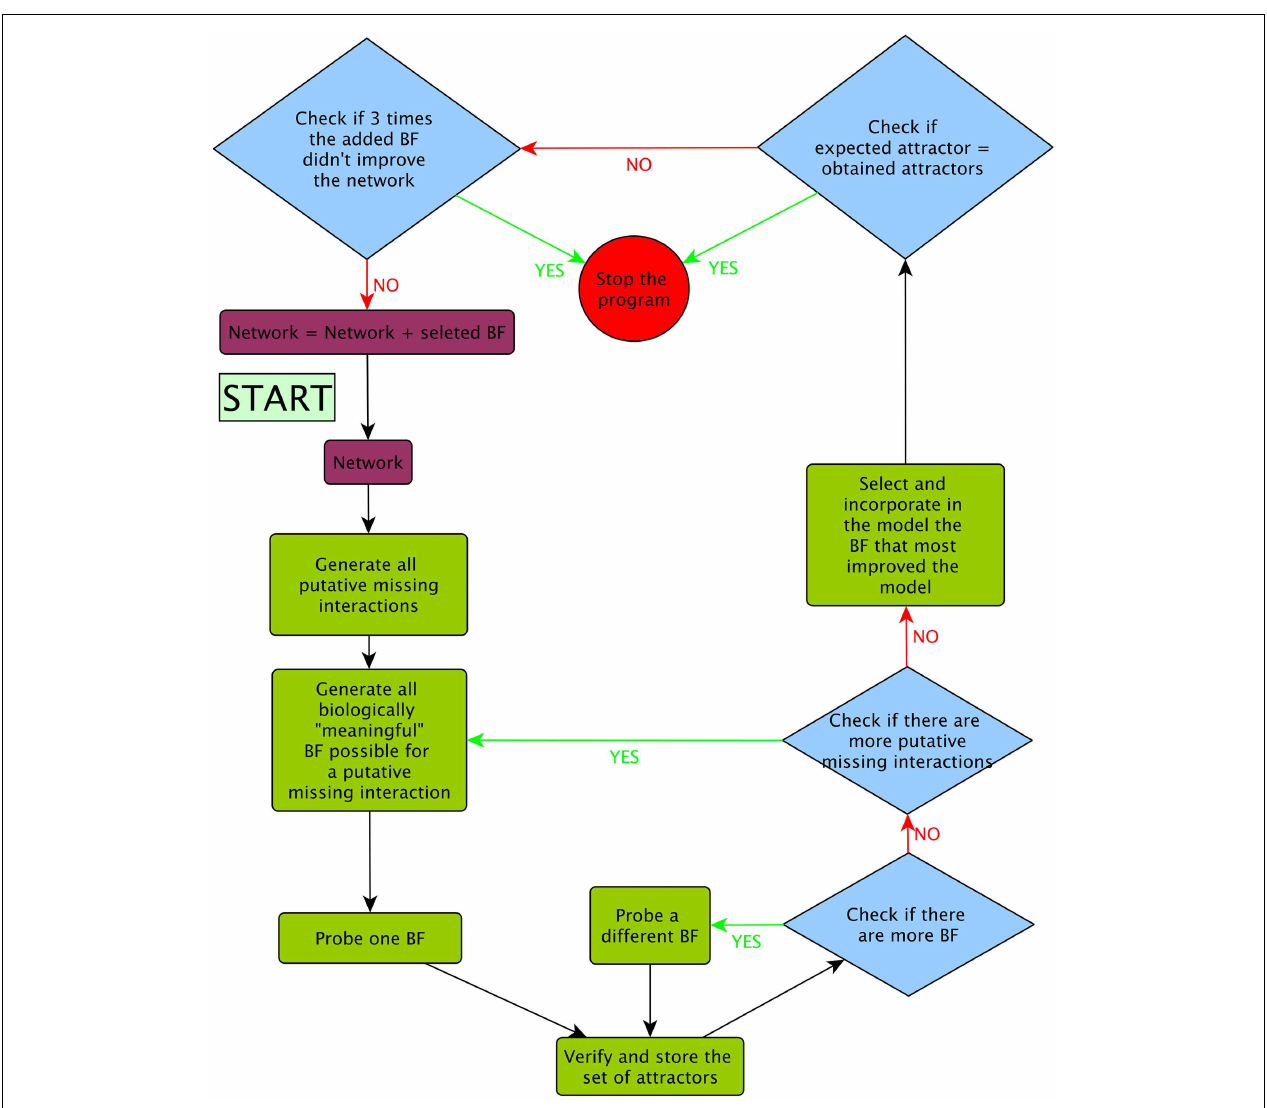
FIGURE 4 | Flux diagram of the evolutionary algorithm followed during the prediction of putative missing interactions using our procedures .